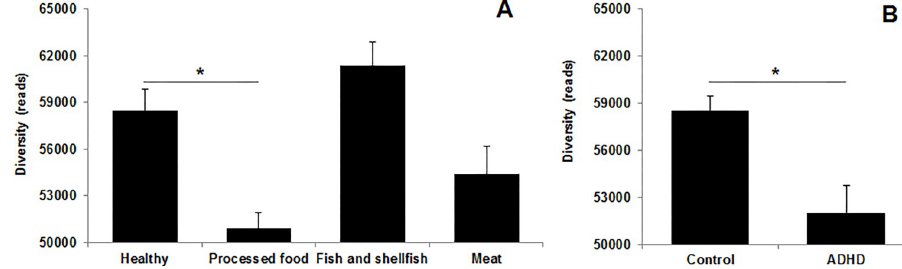
Fig 3. The α -diversity of the gut microbiota. ( A ) Dietary patterns; ( B ) ADHD scores. Values are expressed as the mean ± SEM. Statistical significance was analyzed by ( A ) one-way ANOVA with Duncan’s multiple range test ( � p < 0.05) and (B) Student’s t-test ( � p < 0.05).